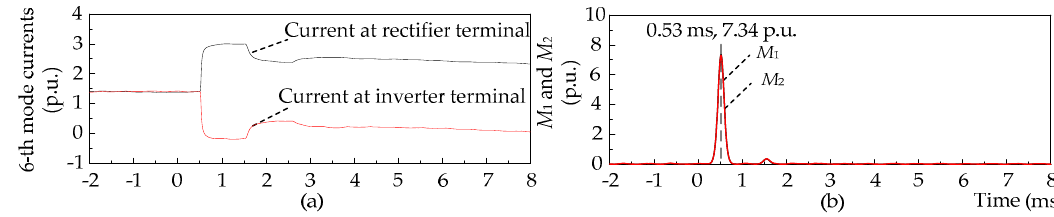
Figure 8. Curves of sixth mode currents and the corresponding M 1 and M 2 during the positive-cable-to-ground (PG) fault with a fault resistance of 100 Ω at the middle point of the cable. ( a ) The sixth mode currents. ( b ) M 1 and M 2 .